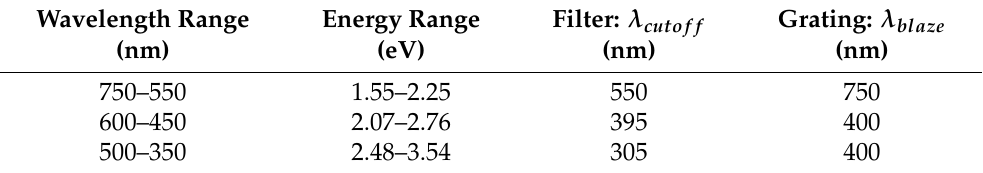
Table 1. Measurement details for the photoconductance spectra: start and end wavelengths (photon energies), cutoff wavelengths of the respective edge filters, and the blaze wavelengths of the monochro- mator gratings for the three overlapping partial